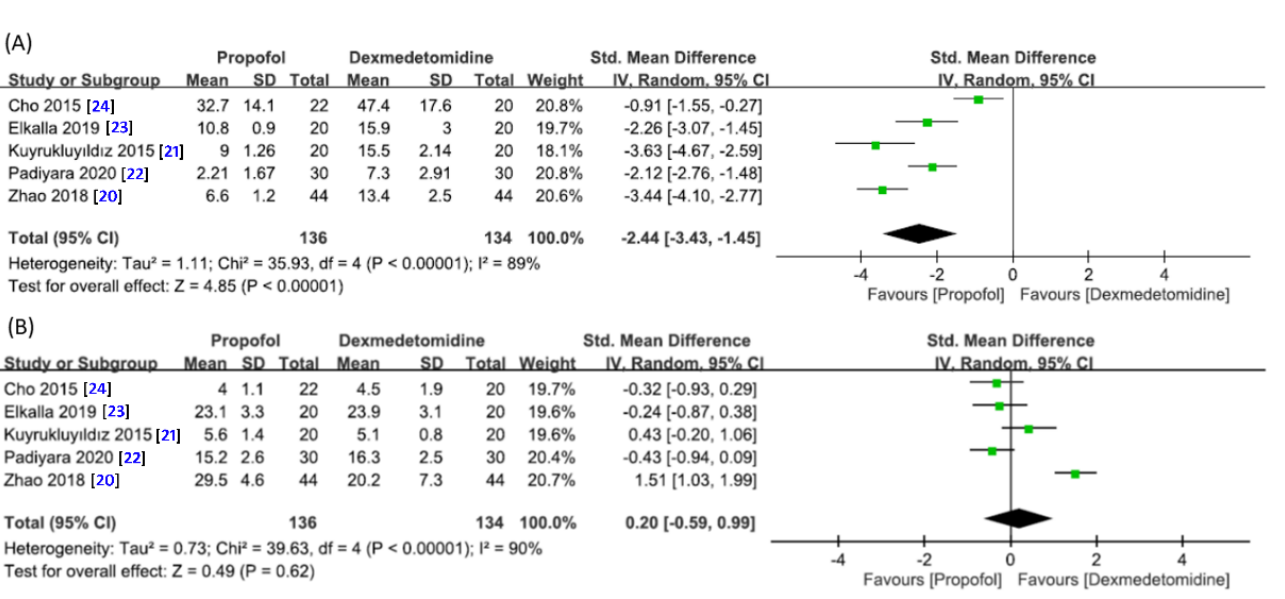
Figure 6. Forest plot for the comparison of ( A ) time to fall asleep and ( B ) duration of endoscopic examination between propofol and dexmedetomidine groups. CI, confidence interval; IV, inverse variance; Std, standardized.